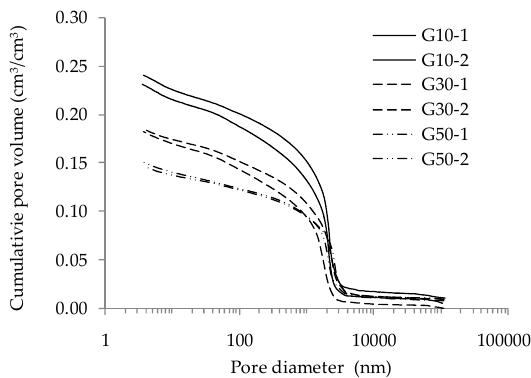
Figure 4. Cumulative pore volume and total porosity of FA-GGBFS blended geopolymers mortars by mercury intrusion porosimetry (MIP).